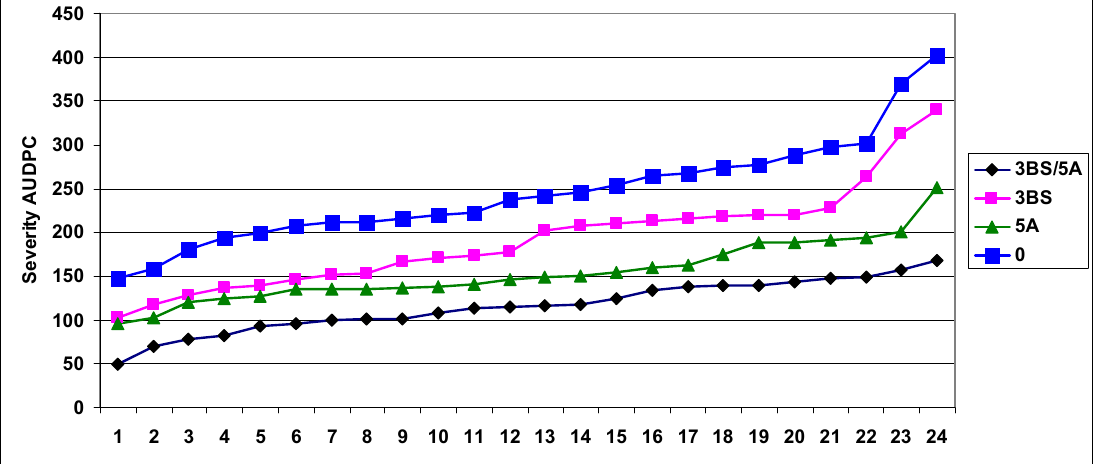
Table 2. ANOVA of the FDK data of the CM82036/Remus population. Source of Variance